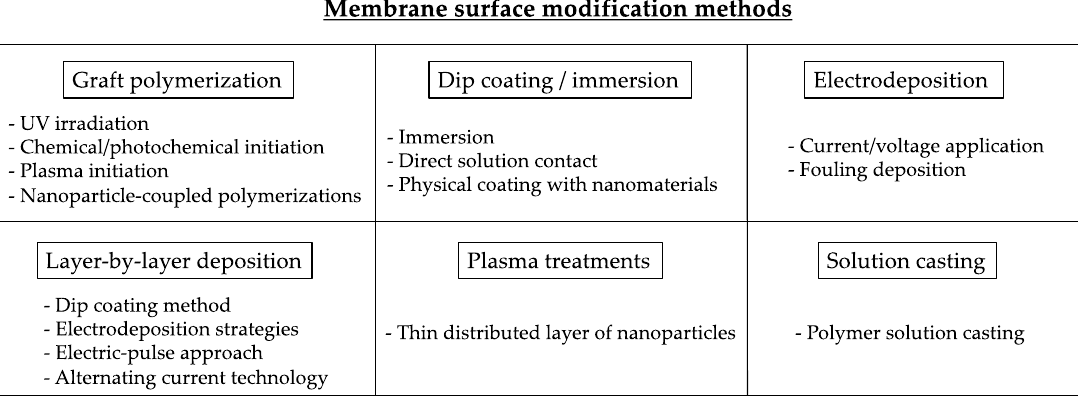
Figure 2. Overview of most frequently applied membrane surface modification